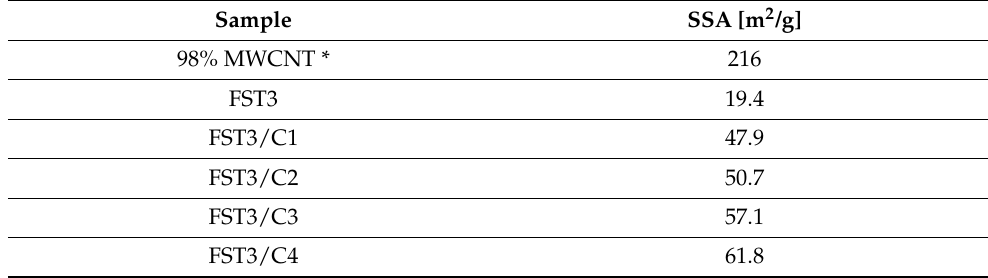
Table 3. SSA for different MWCNT loading on F, Sm 3+ co-doped TiO 2 sample .